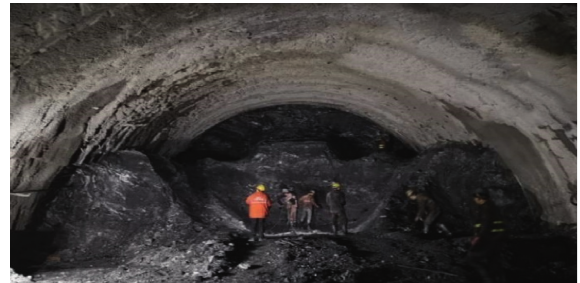
Figure 2: Three-bench circular excavation with reserved core soil